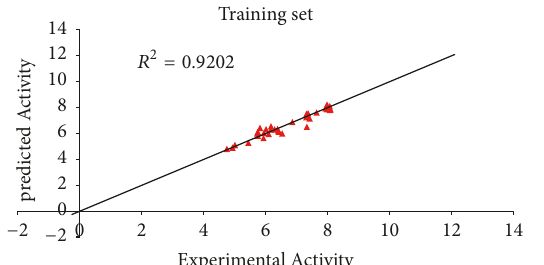
Figure 2: Plot of predicted activity against experimental activity of training set.